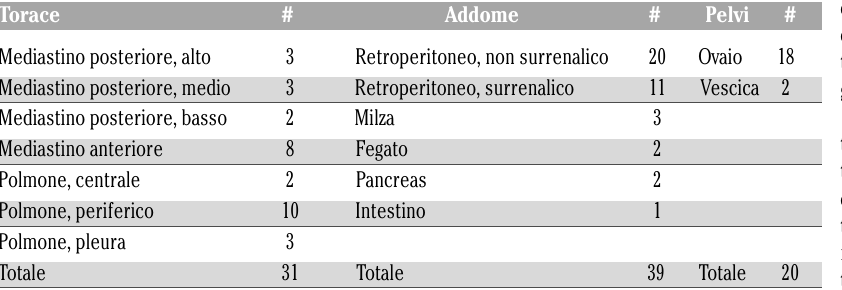
Tabella 2. Le sedi anatomiche di intervento chirurgico - suddivise nei distretti toracico, addominale e pelvico - sono riportate, con le relative